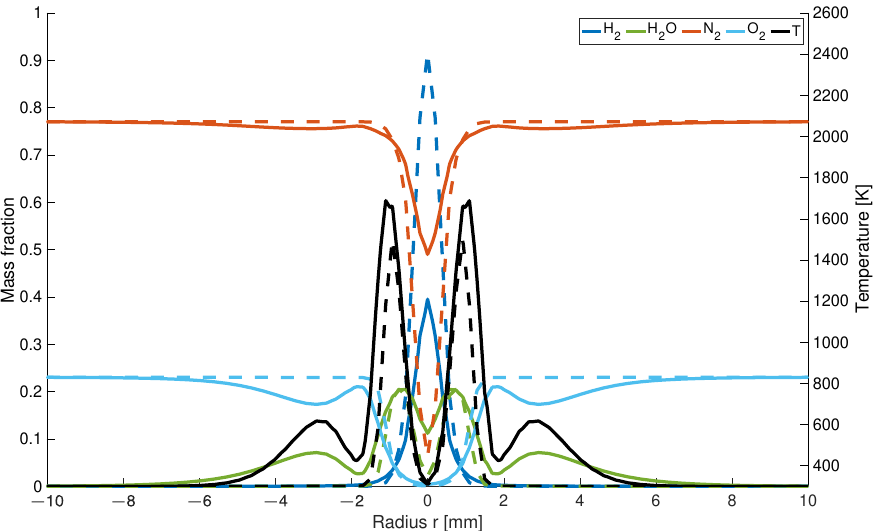
Figure 5. Temperature and mass fraction at a height of 0.5 mm; solid line: with differential diffusion, dashed line without differential